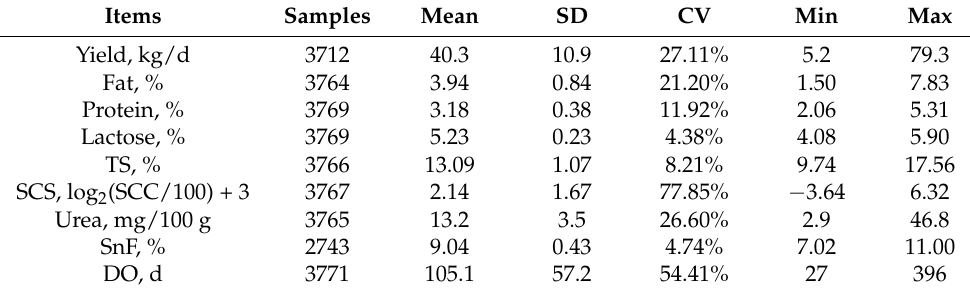
Table 1. Descriptive statistics of milk yield, milk components, and days open